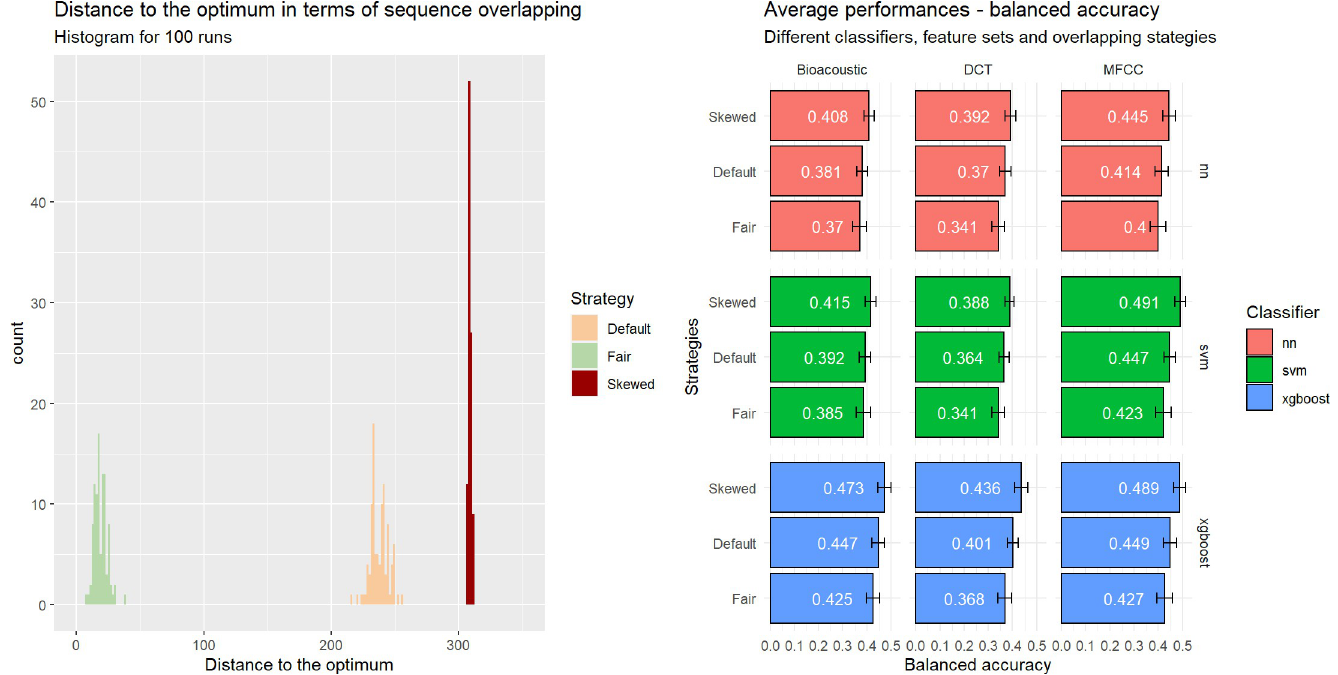
Fig 12. Influence of the sampling on data leakage (all sequences considered). Three scenarios are applied: Default , Fair and Skewed . Left. Distribution of the 100 runs for each strategy in terms of sequence overlap between training and test sets (0: no overlap). Right. Influence of scenario on performance (balanced accuracy) for each combination of classifiers and acoustic feature sets when classifying individual